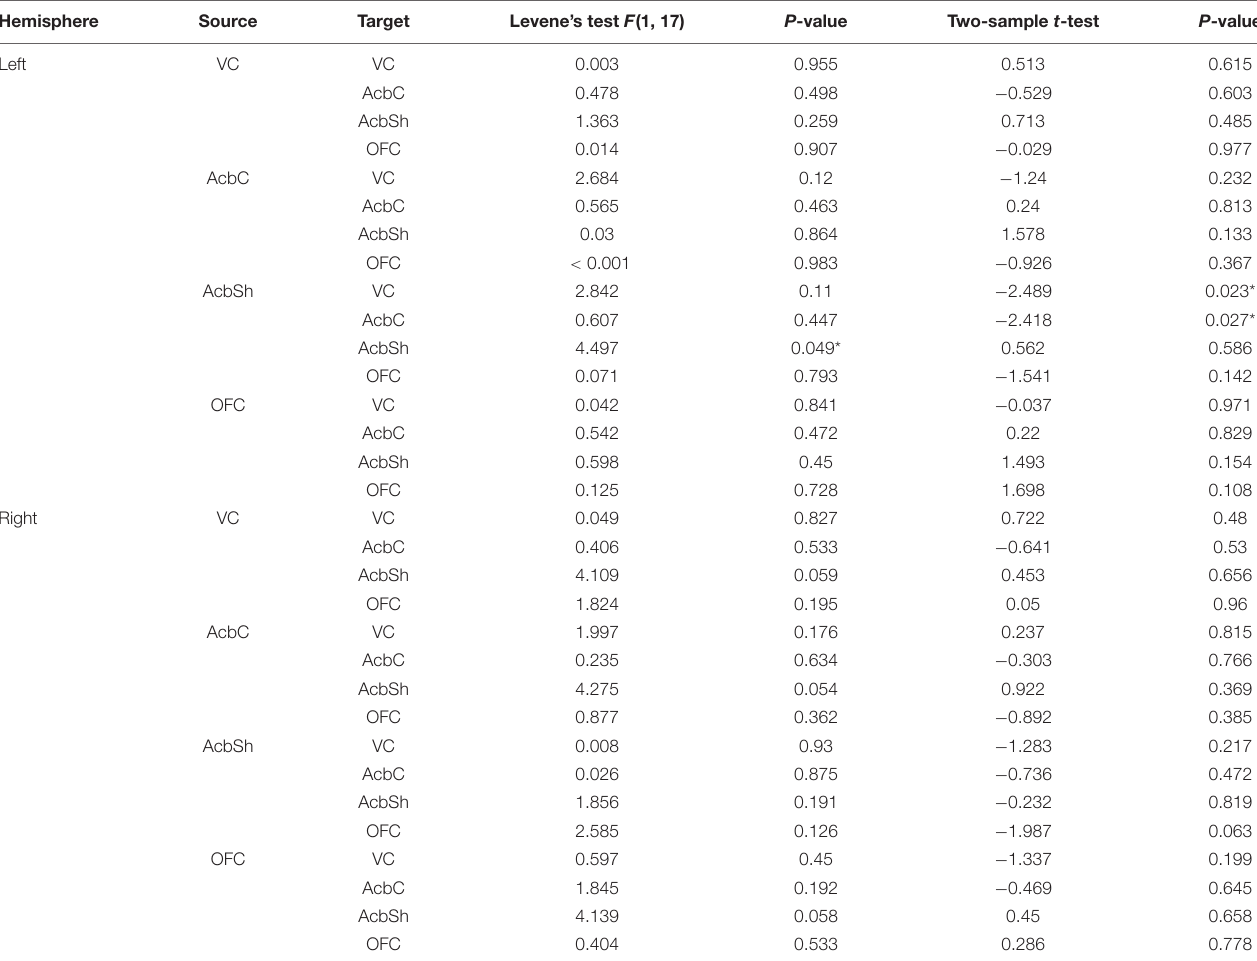
TABLE 4 | Comparisons of EC between vehicle-rTMS and vehicle-sham groups.